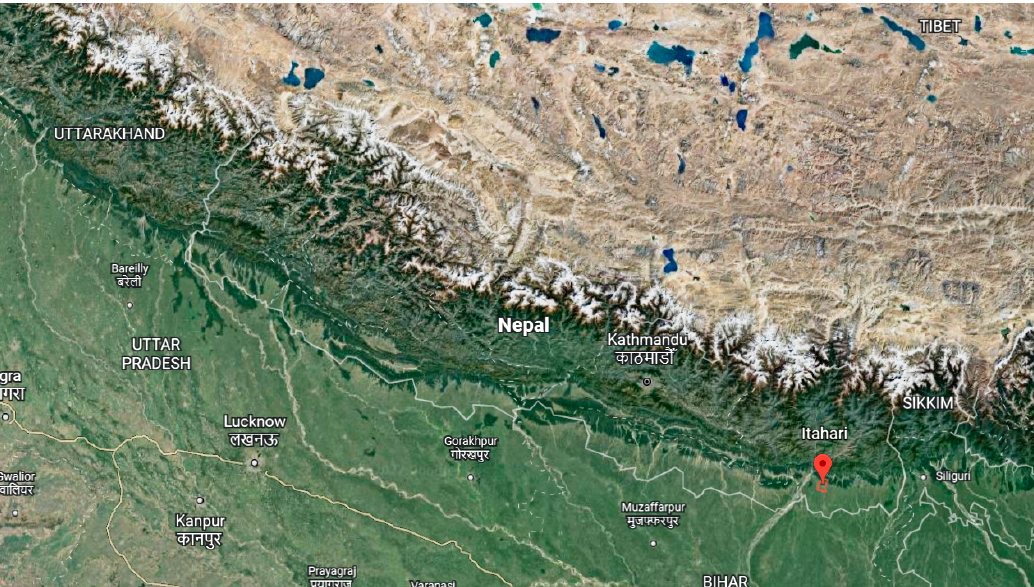
Figure 2. The geographical location of Cymbopogon species collection site from Google Earth.